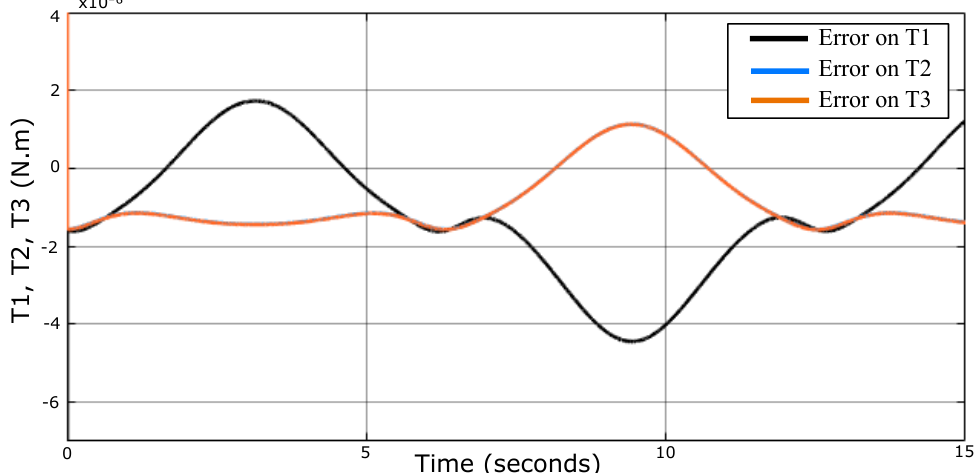
Figure 25. Simulink diagram to test the dynamic model. The torques errors of the delta structure : T1, T2 and T3